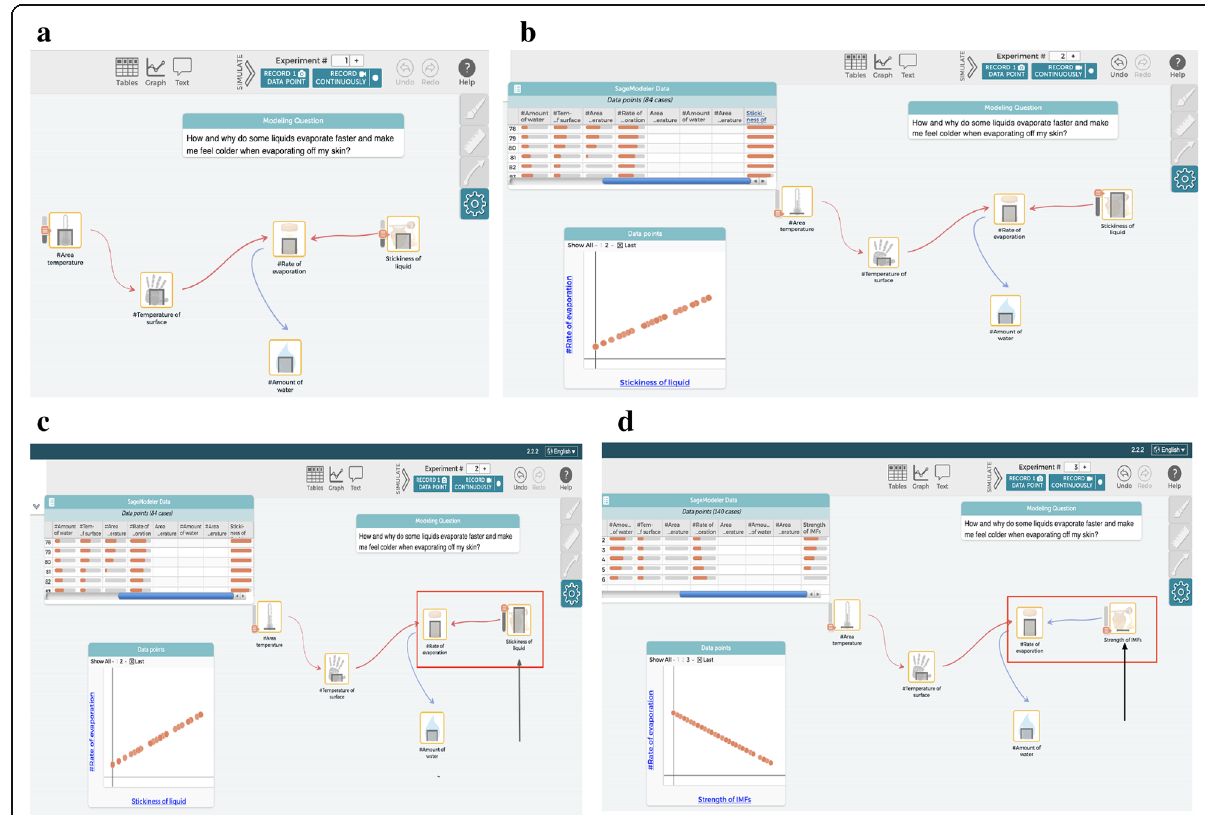
Fig. 2 Iterative revisions of students ’ models through engaging in CT: testing and debugging, data generation, and iterative